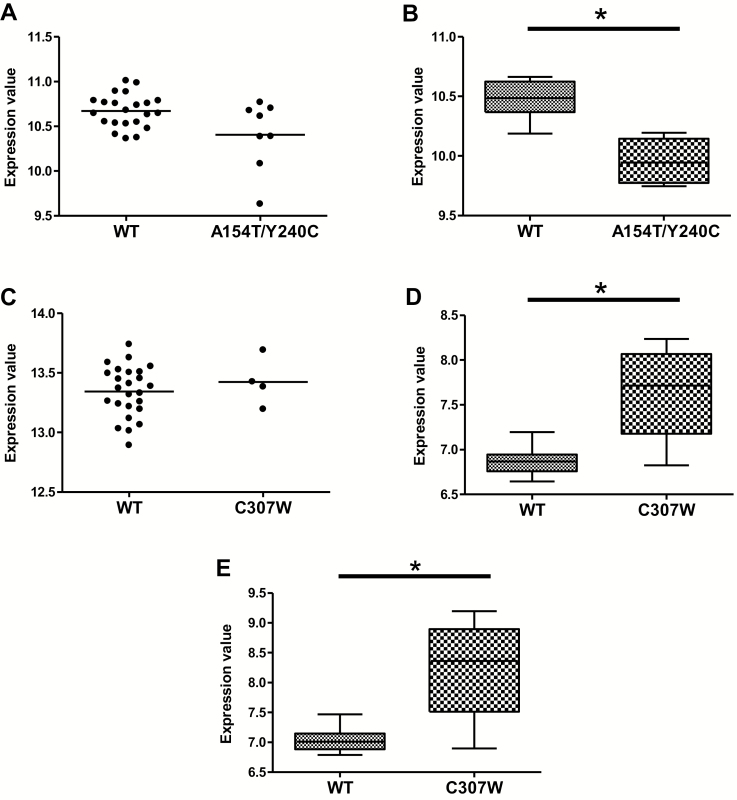
Variant impact on downstream transcriptomics. A, Rectal expression of TPMT is not affected by the 2 observed TPMT variants (A154T/Y240C), (B) whereas the variants demonstrate a significant downstream impact on SPOP expression within the rectum. C, Expression of SLC26A3 within the colon is not affected by variant status (C307W), but (D) and (E) carriers of this mutation demonstrate an increase in DUOXA2 and DUOX2 expression within the rectum. *Adj P < 0.05.